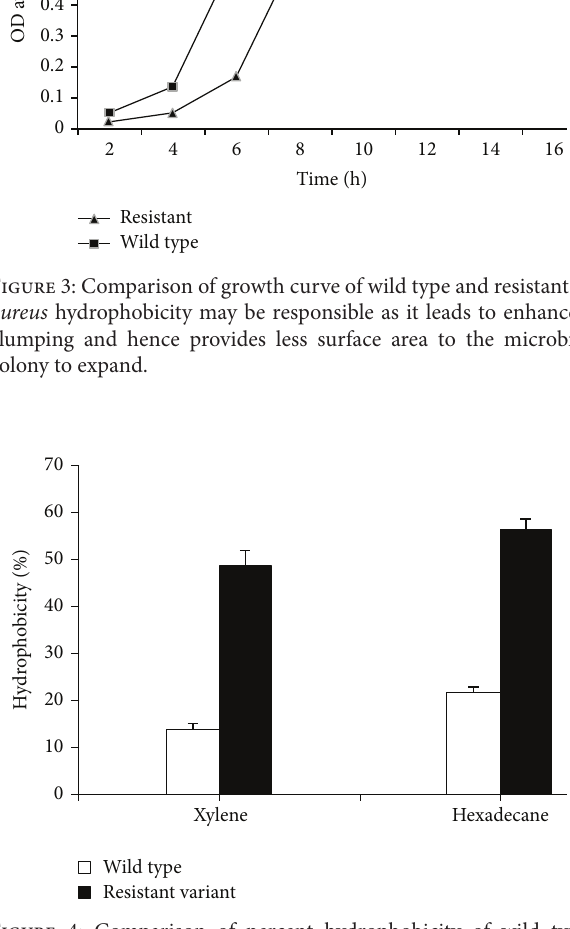
Figure 4: Comparison of percent hydrophobicity of wild type and resistant strain of S. aureus . Values are mean ± SD of three independent determinations ( 𝑛 = 3